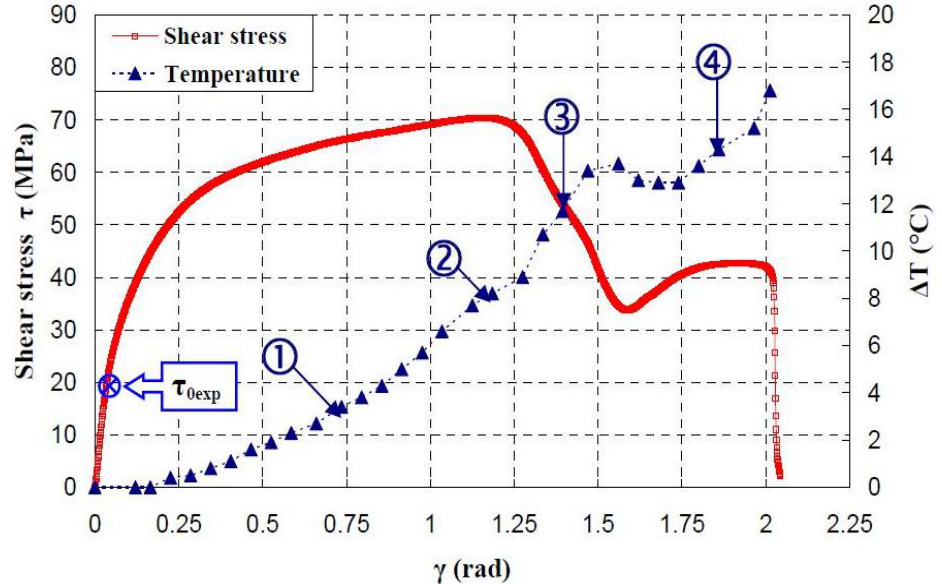
Figure 23. Thermal dissipation and shear stress of PA66 polymers during the torsion test.